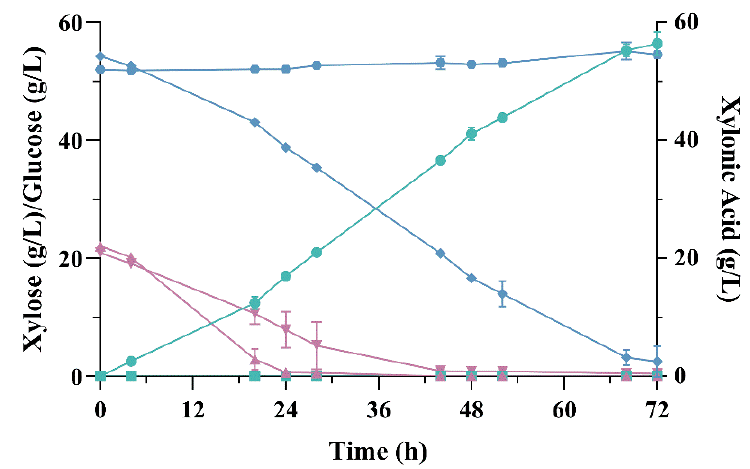
Figure 4. Fermentative profile of strains ZMa BX and ZMa C-. Fermentation was carried out in a bioreactor with modified RM medium containing 50 g L − 1 xylose in batch mode at 30 °C. Xylonic acid production by ZMa BX (green circles), xylose (blue diamonds) and glucose (purple triangles) consumption by ZMa BX; xylonic acid production by ZMa C- (green squares), xylose (blue hexagons) and glucose (purple inverted triangles) consumption by ZMa C-.